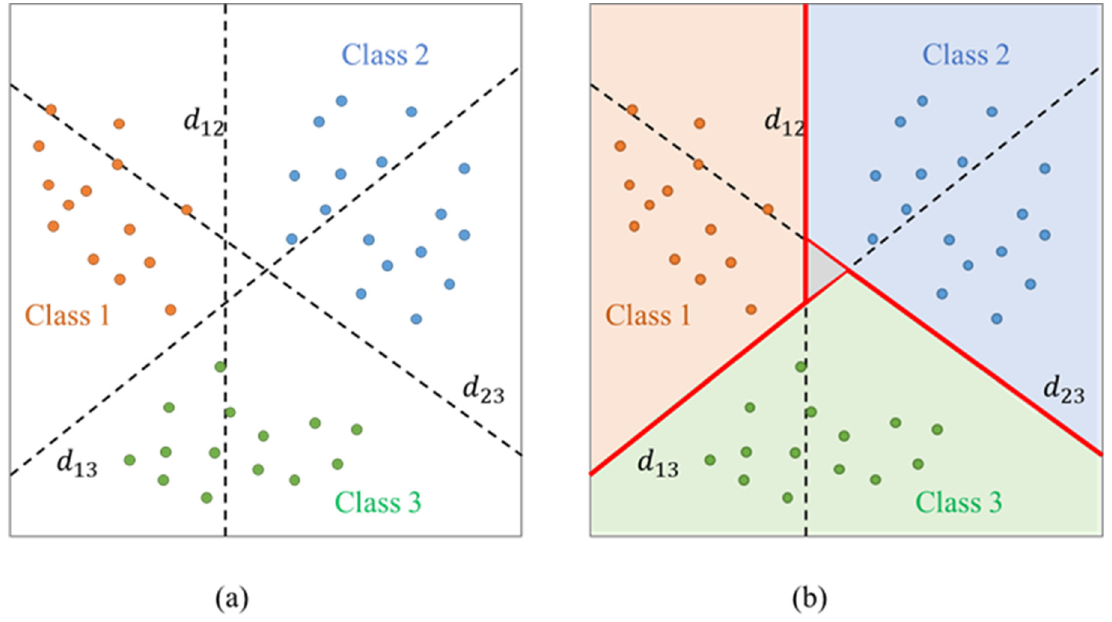
Figure 7. The paired classification method. ( a ) Decision boundary, ( b ) Decision boundary drawn according to the voting